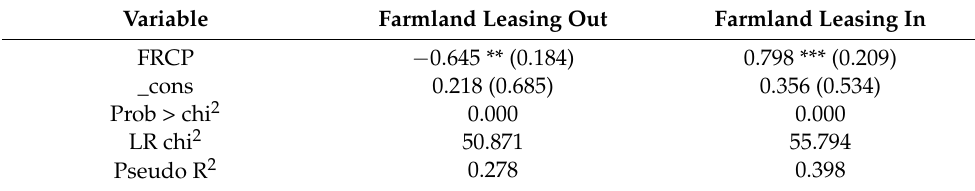
Table 3. Estimation results of the impact of FRCP on farmland transfer behavior. Variable